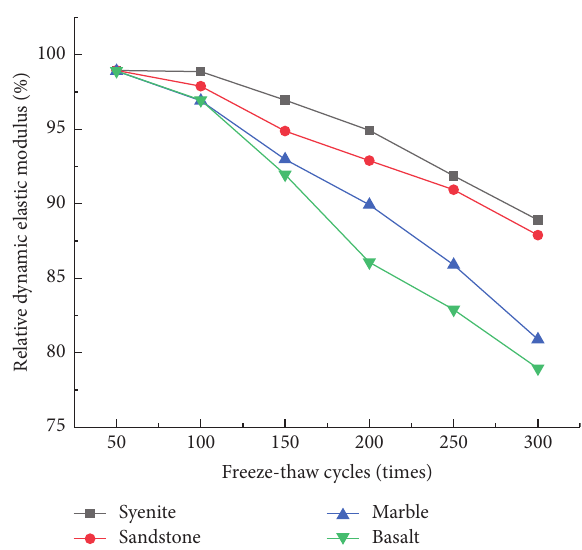
Figure 7: Relative dynamic elastic modulus of concrete during freeze-thaw cycles.